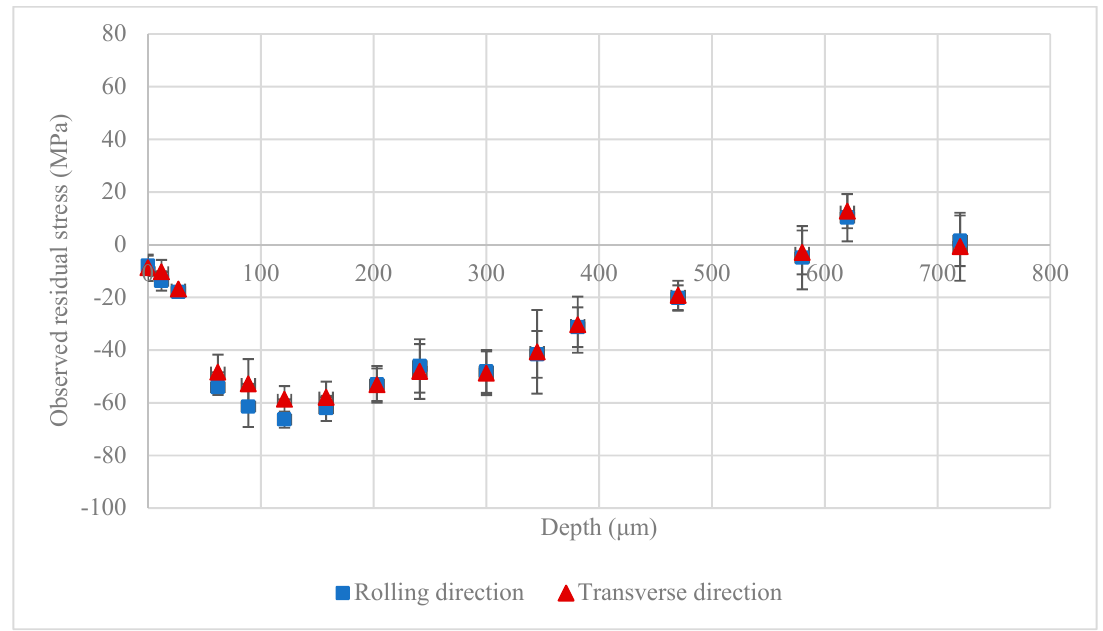
Figure 5. Observed (before proposed stress correction) residual stress on the peened AZ31B-H24 plate with steel shots; data points correspond to measurements after each layer removal.